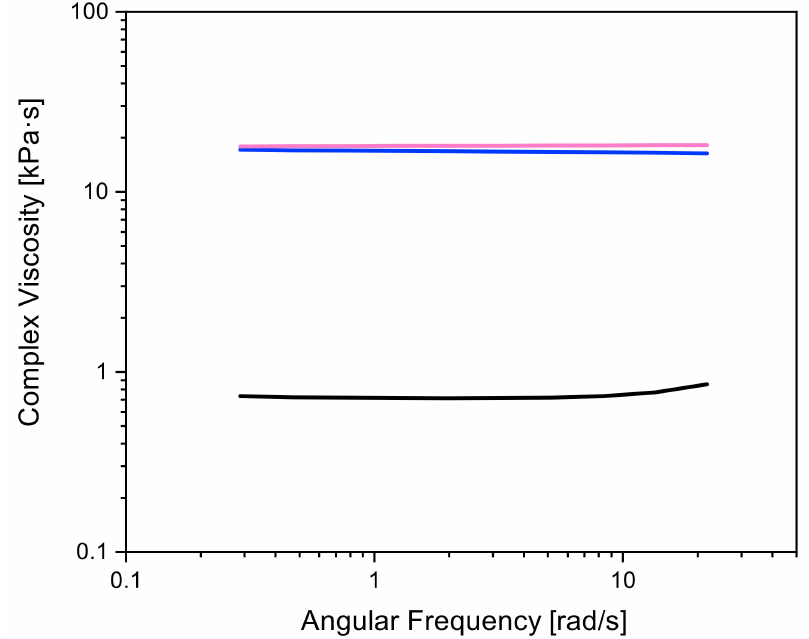
Figure 4. E ff ect of n -octyloxy side chains on the complex viscosity. From top to bottom: PPM (pink line), 6.1% mol / mol octyloxy units (blue line) and 13.4% mol / mol octyloxy units (black